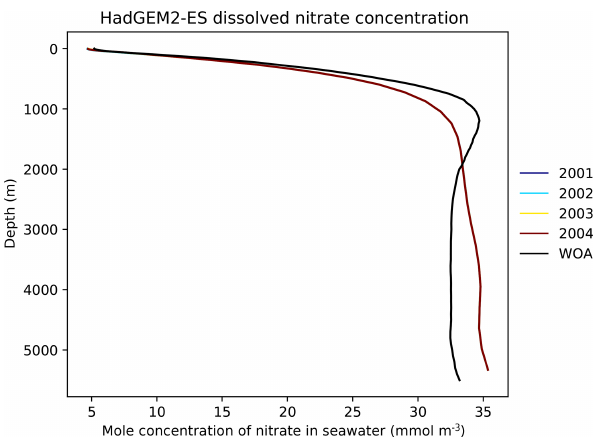
Figure 40. The global area-weighted average depth profile of the dissolved nitrate concentration in the CMIP5 HadGEM2-ES model and against the World Ocean Atlas 2013. Produced with recipe_ocean_bgc.yml ; see details in Sect.